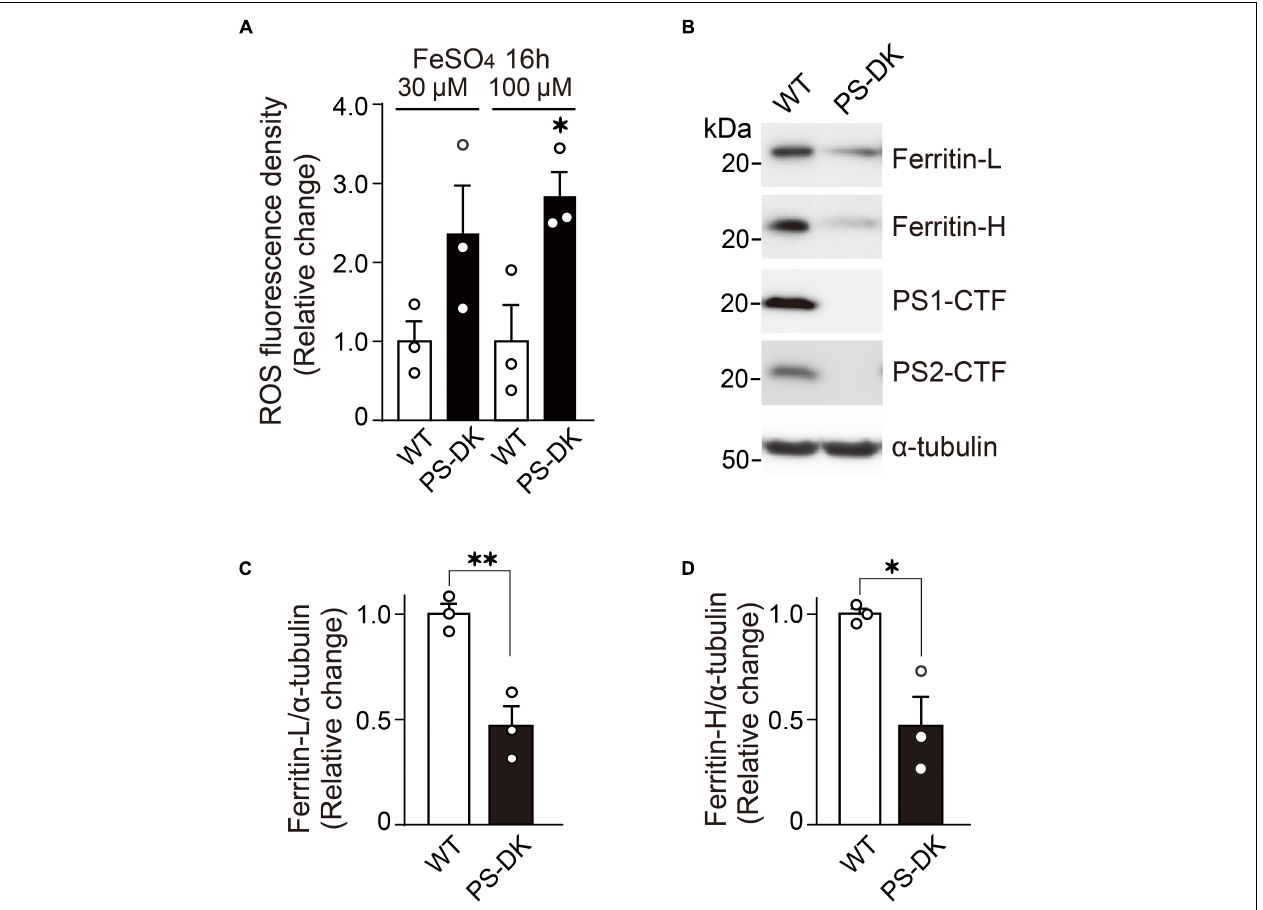
FIGURE 2 | PS-DK fibroblasts generated more ROS by iron-treatment and showed lower intracellular ferritin levels than wild-type fibroblasts. (A) ROS fluorescence density were measured 16 h after treatment with ferrous sulfate. PS-DK fibroblasts showed higher ROS levels after iron-treatment. n = 3, from 3 independent experiments, ∗ P < 0.05, unpaired two-tailed Student’s t -test. (B) Western blot analysis of intracellular ferritin light and heavy chains, PS1 C-terminal fragment (CTF) and PS2 CTF. (C,D) Quantification of intracellular ferritin light and heavy chain levels. Their levels were normalized to α -tubulin protein levels. n = 3, from 3 independent experiments, ∗ P < 0.05, ∗∗ P < 0.01, unpaired two-tailed Student’s t -test. All quantitative data shown as mean ± SEM. Ferritin-L, ferritin light chain. Ferritin-H, ferritin heavy